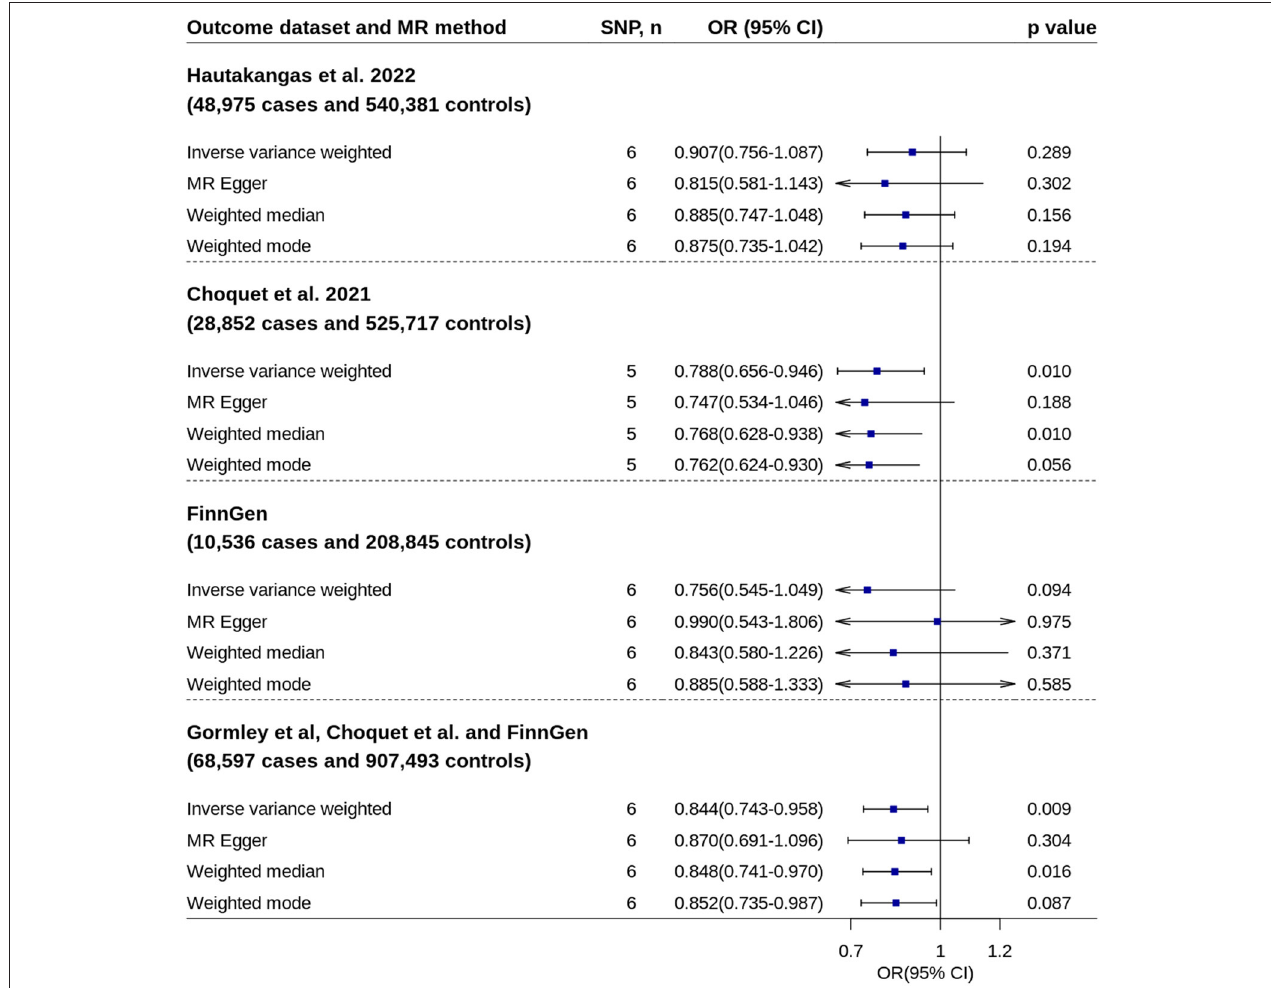
FIGURE 4 | Replication analyses of 25OHD on migraine risk. No outlier was detected by MR-Pleiotropy Residual Sum and Outlier. 25OHD, 25-hydroxyvitamin D; CI, confidence interval; MR, Mendelian randomization; OR, odds ratio; SNP, single nucleotide polymorphism.